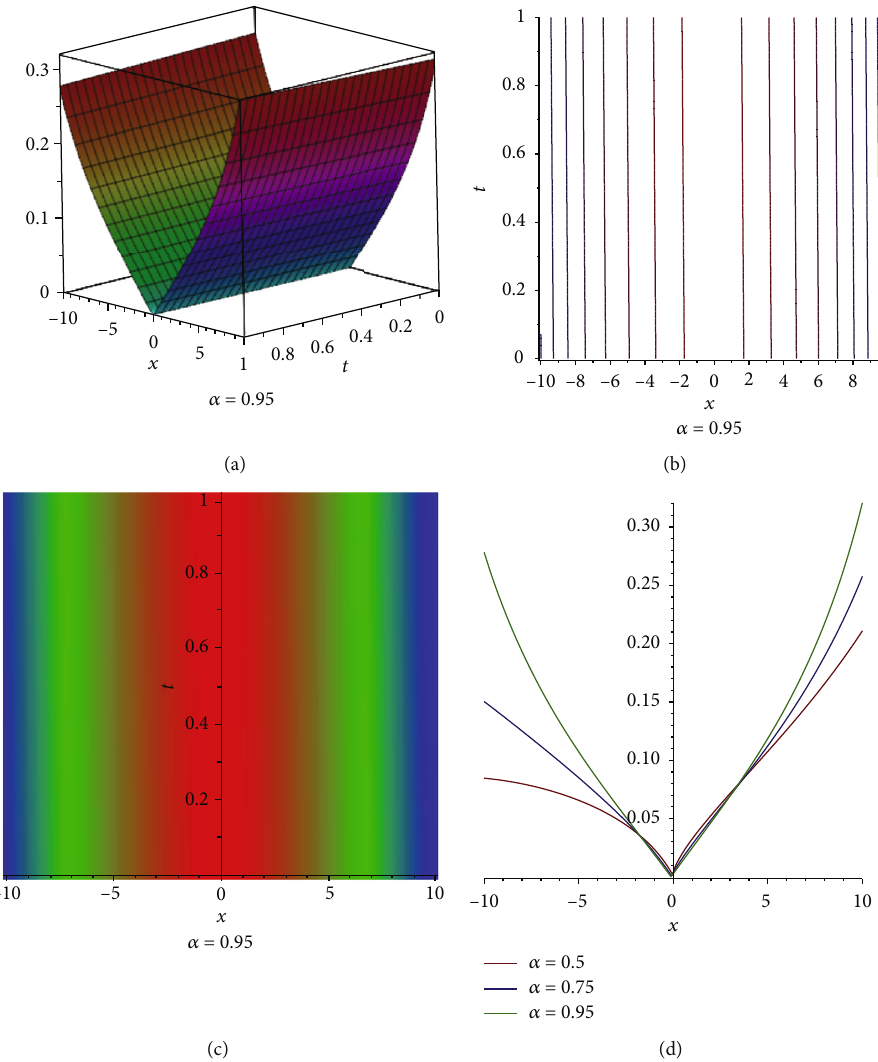
= 0 : 63, δ = δ = w = w = 1 2 3 1 2